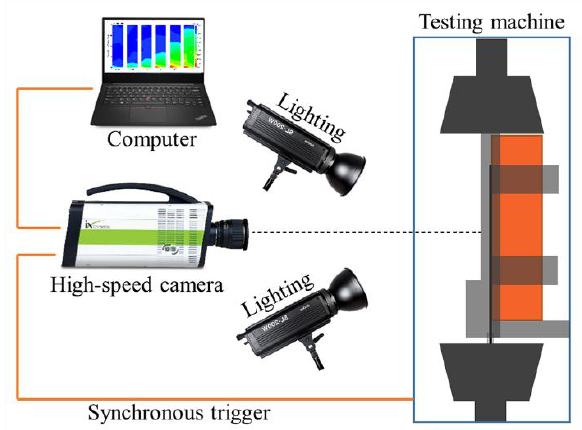
Figure 3. The strain measurement system by digital image correlation (DIC).